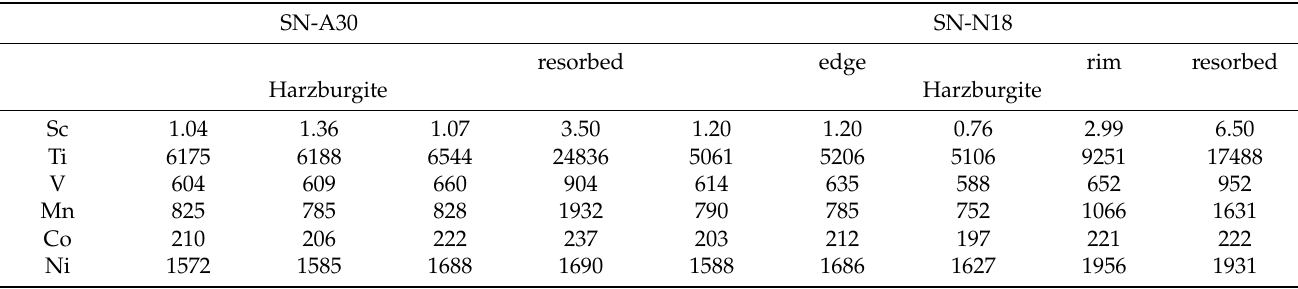
Table 4. Representative trace element compositions of spinel in non-lherzolite upper mantle xenoliths from Jetty Peninsula